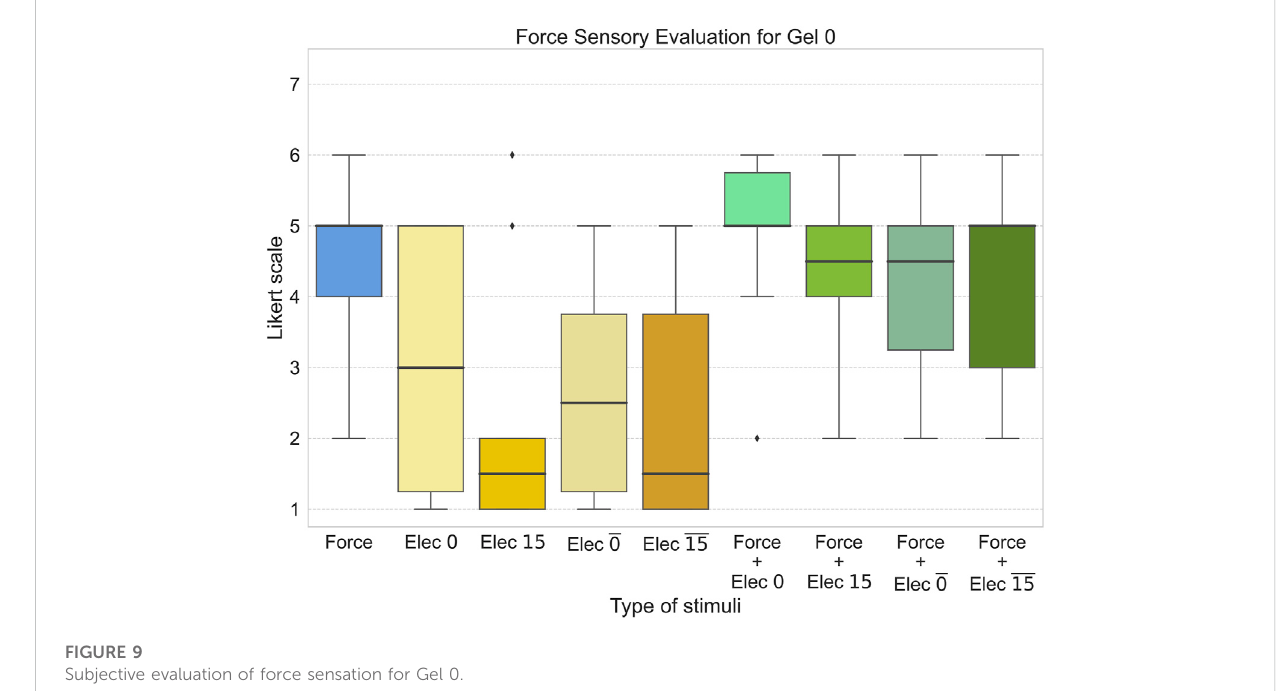
Subjective evaluation of force sensation for Gel